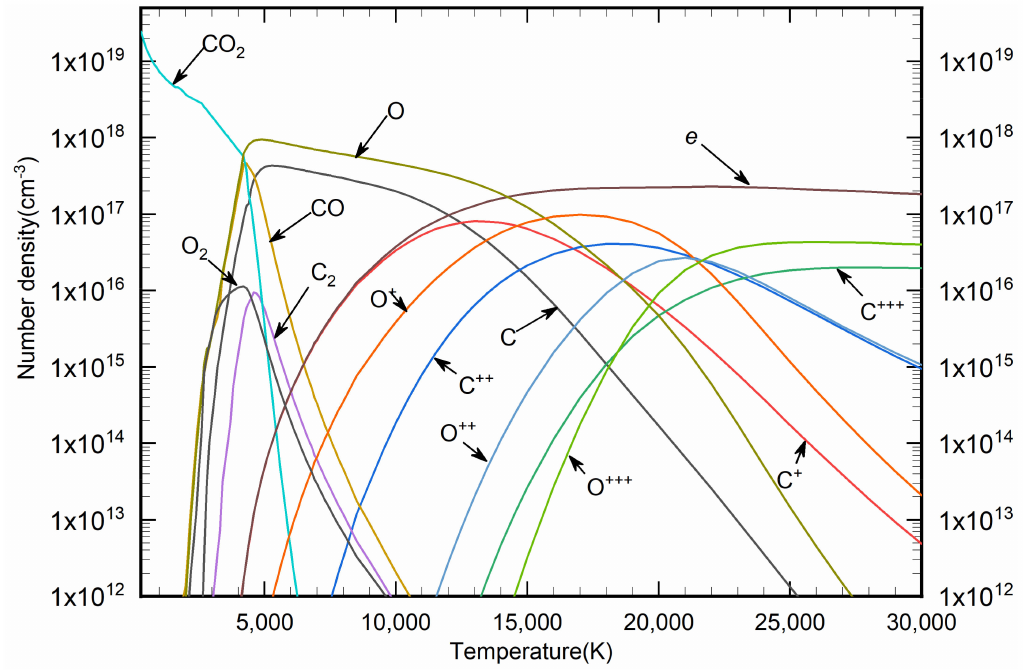
Figure 5. Equilibrium compositions of pure CO 2 mixture plasma at temperatures of 300–3000 K and a pressure of 0.1